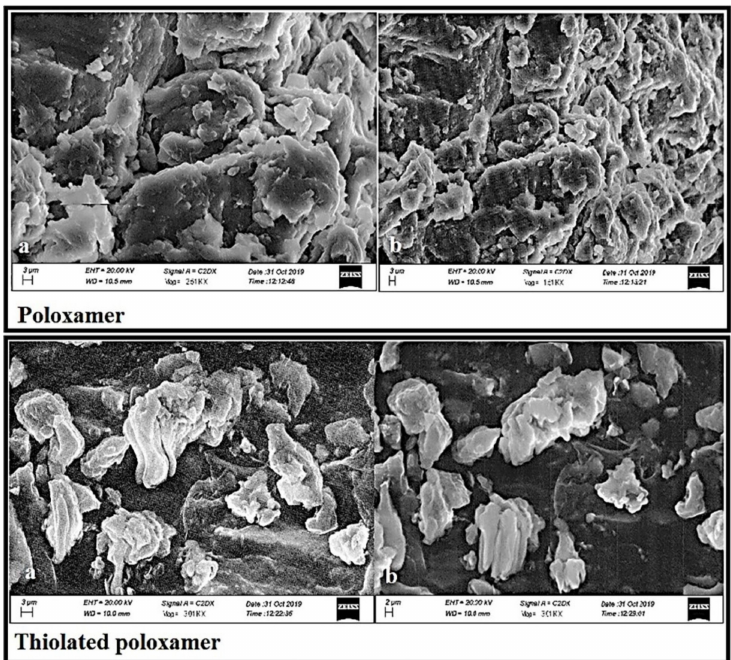
Figure 4. SEM images describing the surface morphology of PLX and TPLX at different magnifications ( a ) 1000X and ( b ) 500X. A change in the apparent surface morphology of TPLX can be observed, thus indicating the chemical modification of PLX.